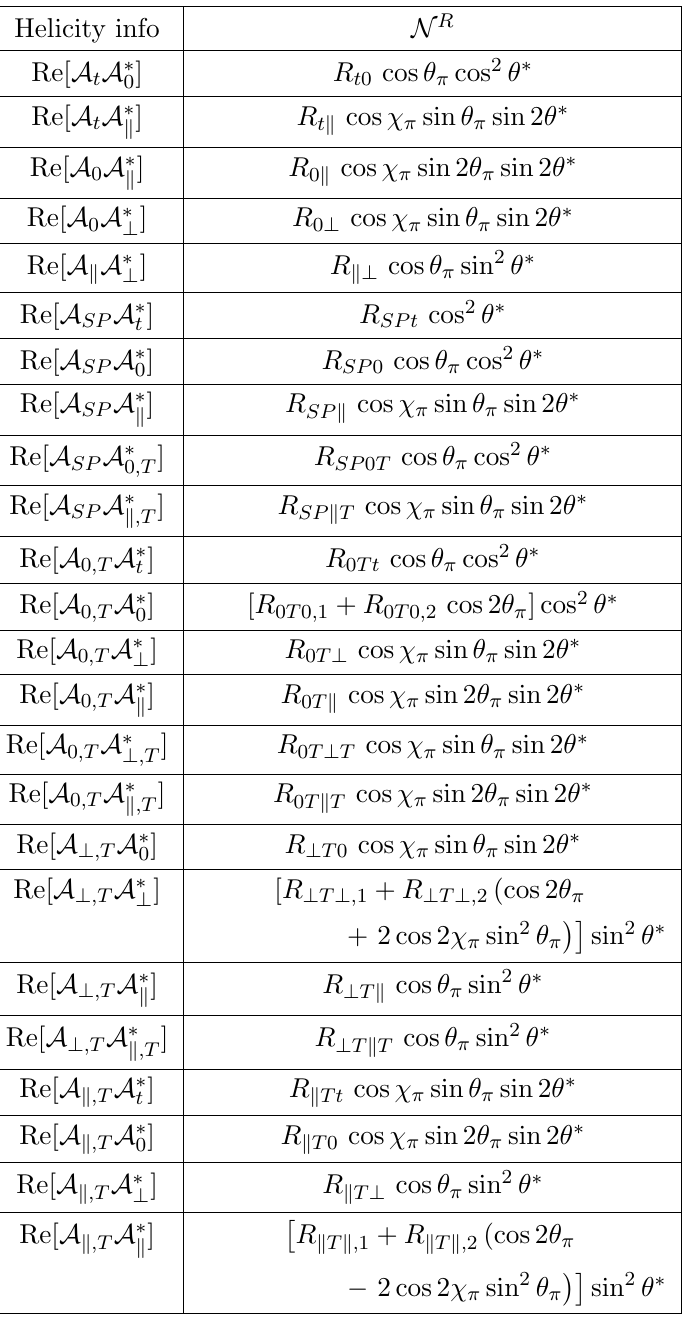
Re[ A i A (cid:3) ] pieces of eq. (2.15). The coe(cid:14)cients R i depend on i;j j